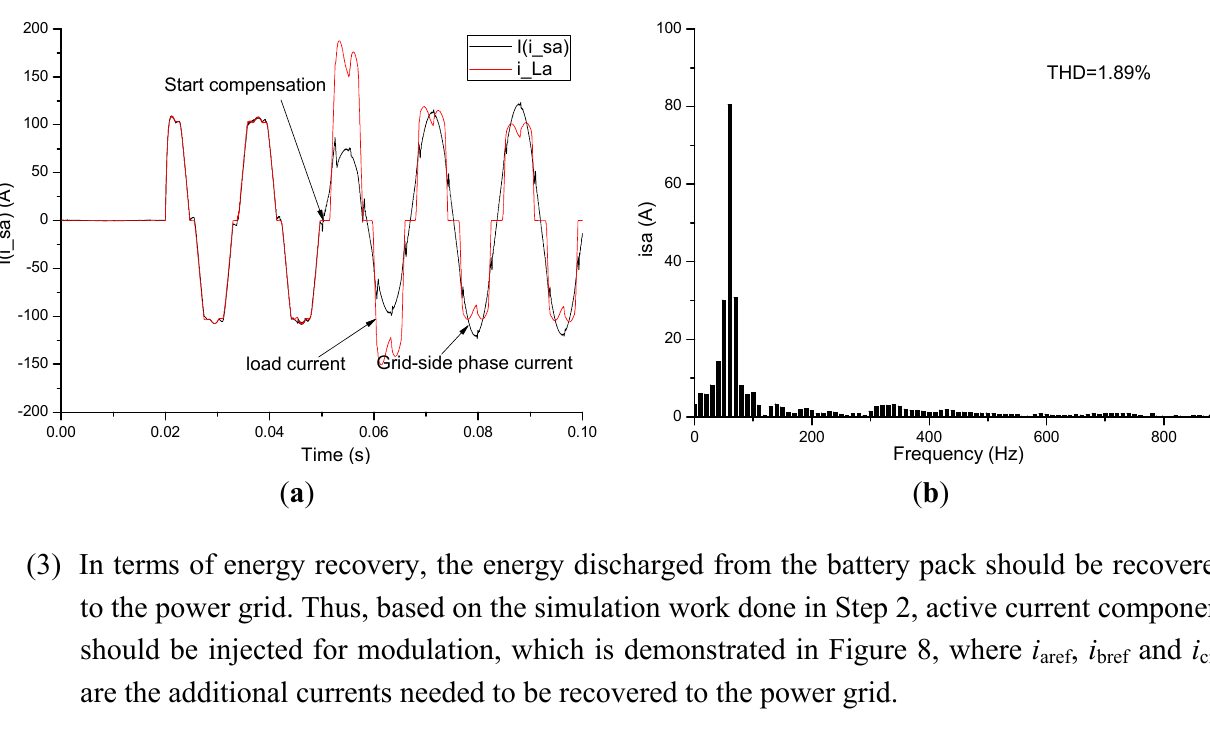
Figure 8. Multi-functional ERPABPTS using the proposed